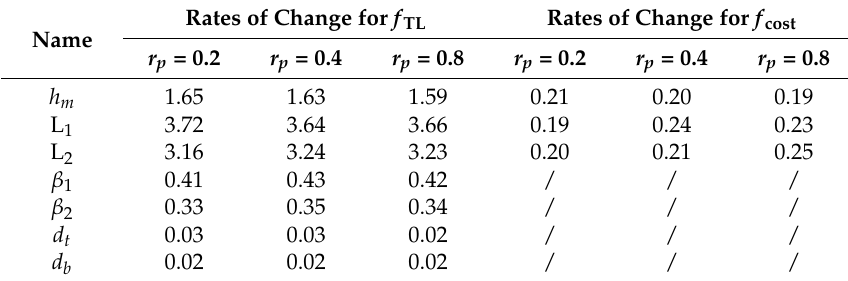
Table 5. Sensitivity analysis of the rotor.